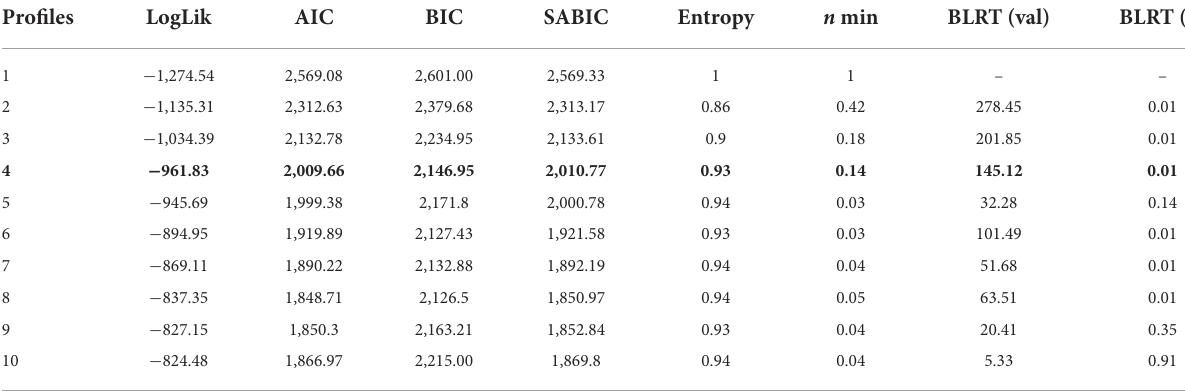
TABLE 1 Model fit indices from the latent profile analyses of co-care experiences at T1 ( N = 180).